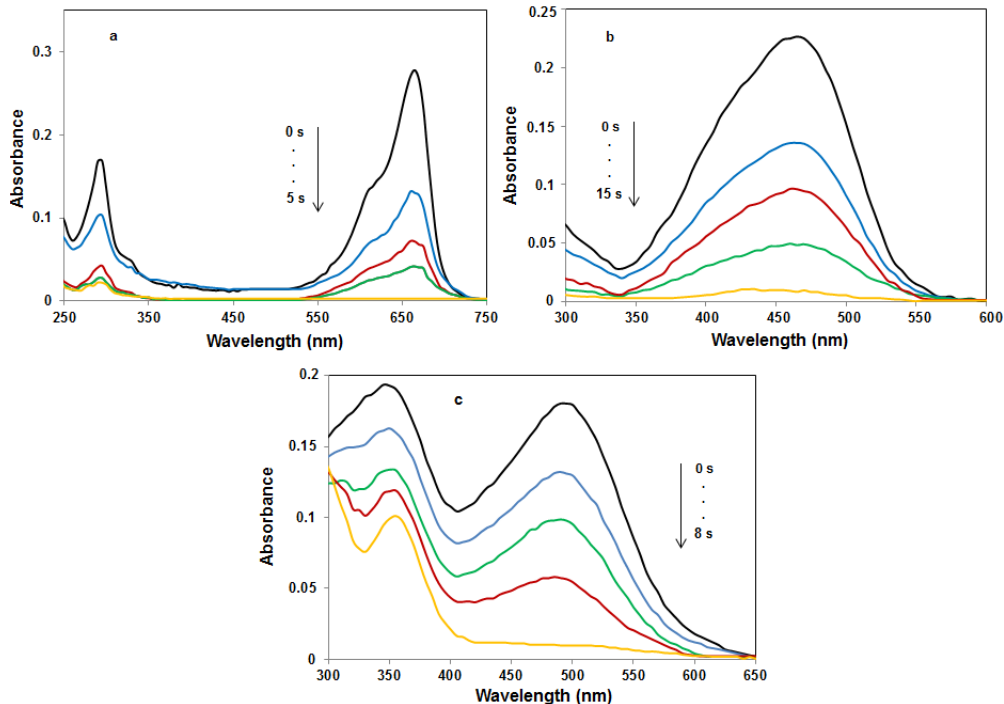
Fig. 5. Absorption intensities of MB (a), MO (b) and CR (c) solutions during the catalytic reduction. Table 1. Reduction times of selected dyes (90 mL, 10.0 ppm) in the presence of catalyst (4 mg) using NaBH 4 (5 mg). Catalyst